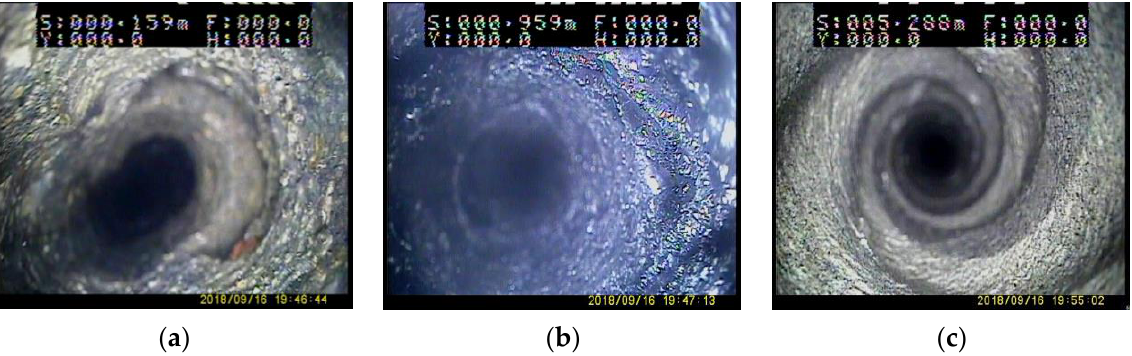
Figure 3. Peeking observations of the roadway boreholes. ( a ) Mudstone — badly fractured. ( b ) Coal seams — medium break. ( c ) Medium sandstone — surrounding rock intact.